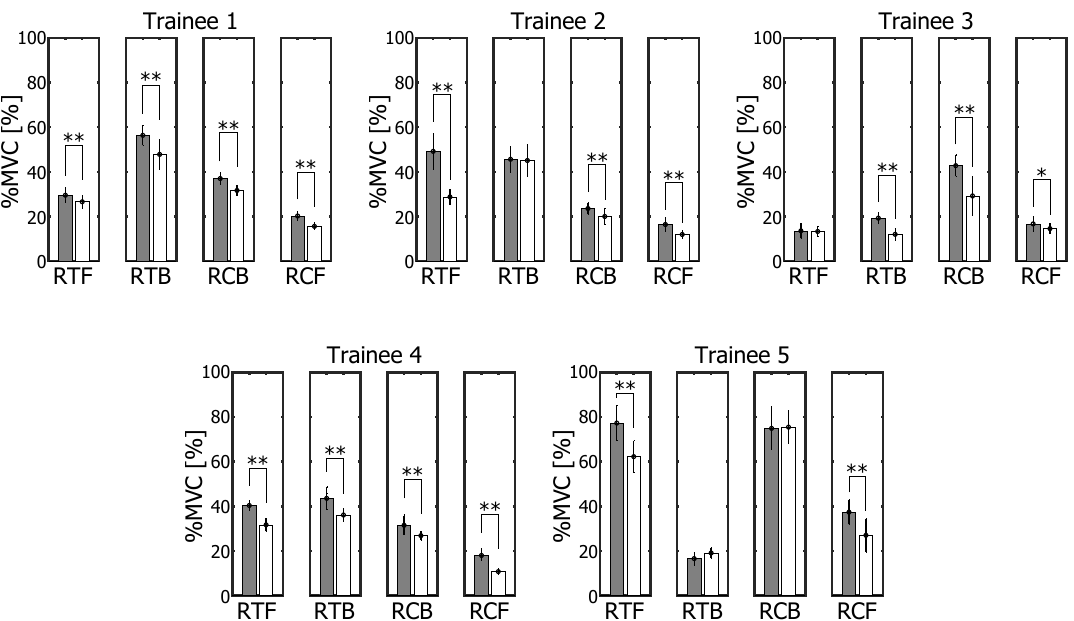
Figure 16. Results of EMG evaluation experiment. The vertical axis represents % MVC value in each electrode. The white and gray bars are the average % MVC values with assist and without assist which are calculated from 20 cycle data. The black thin bars are the standard deviations. The symbols ∗ and ∗∗ indicate that the values are statistically different at the significance level of 5% and 1% of the two-sided